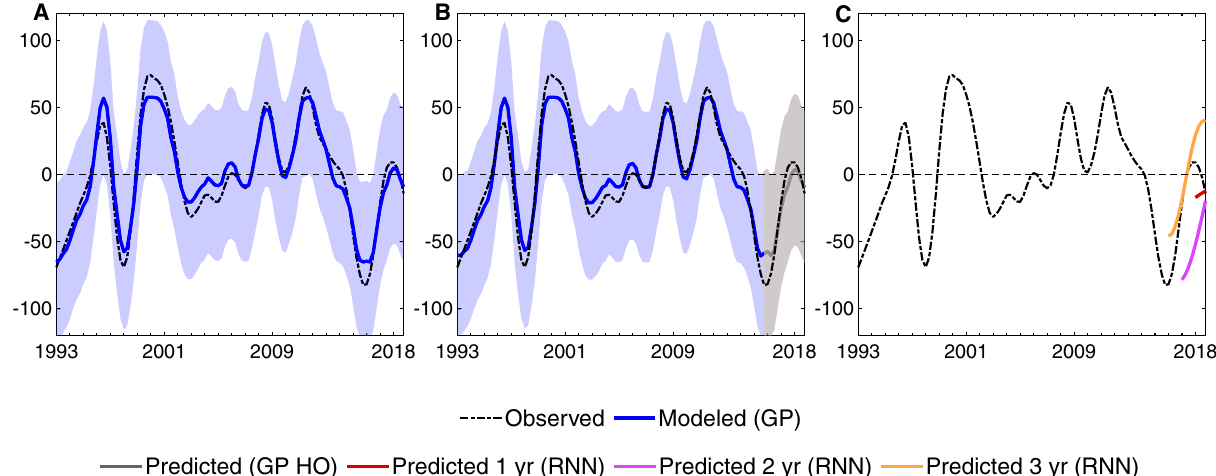
Figure 3. The regional modeled and predicted patterns are consistent with observed sea level variability. ( A ) Time series of the GP model (in blue) and observed sea level estimates (black) for the west Pacific Ocean region (shown in Fig. 2). ( B ) Same as in A but here the holdout method was used to predict sea level for the last 3 years of the record (in gray) by training the GP model from 1993 to 2015. ( C ) Sea level predictions for 1 (red), 2 (purple) and 3 (orange) years using the RNN method by training the observed sea level estimates (black) from 1993 to 2017, 2016 and 2015, respectively. The shaded envelops depict 95% prediction intervals. Sea level expressed in